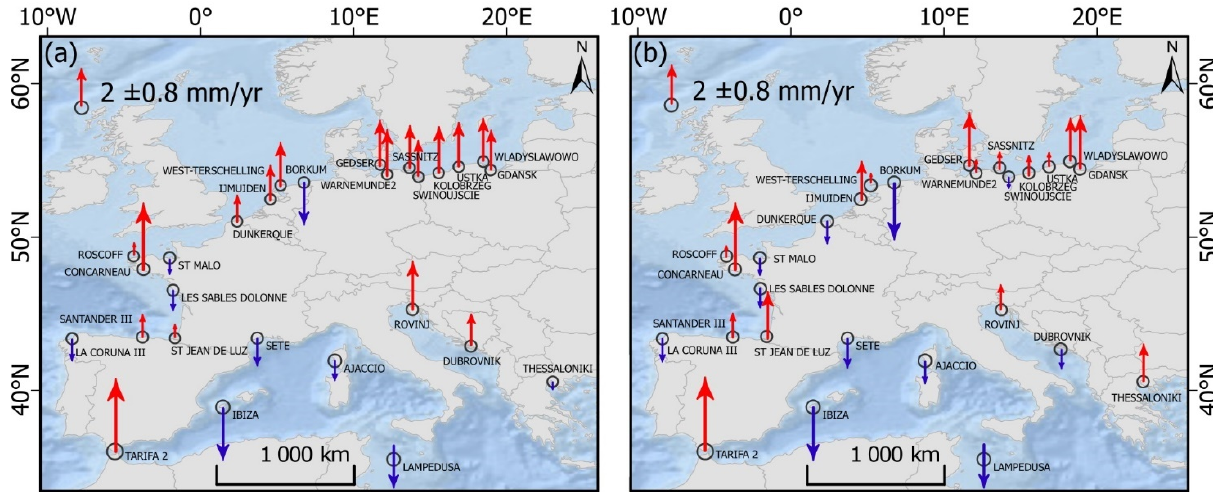
Figure 13. ( a ) Map of vertical crust movements in coastal stations estimated from different time series of SA data minus TG data (from the beginning of data to 2018). ( b ) Map of vertical crust movements in coastal stations estimated from different time series of SA data minus TG data (1993–2017); the units on both pictures are in mm/year. The linear trend standard errors are visualized by black circles. Positive values of the linear trend are visualized by a red arrow. Negative values of the linear trend are visualized by a blue arrow.